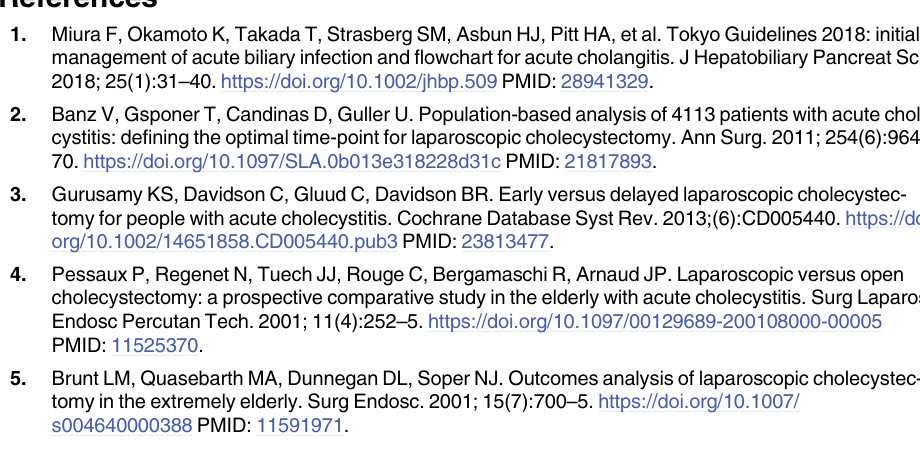
S1 Table. Baseline characteristics of patients with successful SpyDS assisted cystic duct cannulation. S2 Table. Baseline characteristics of patients with endoscopic transpapillary gallbladder stenting (ETGBS) and endoscopic nasogallbladder drainage